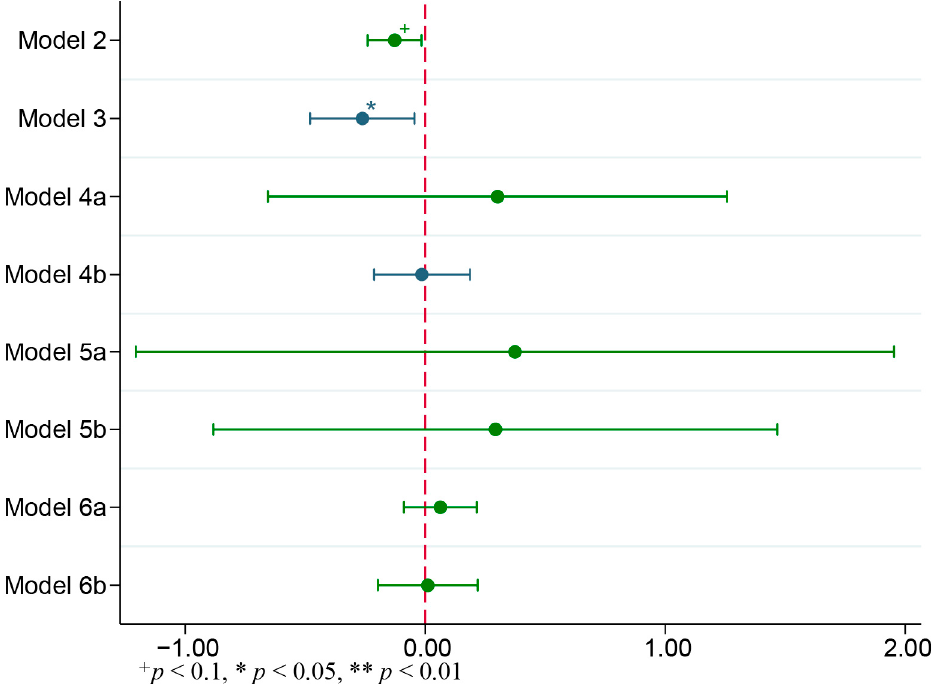
Figure 2. The regression results of all respondents. Note: Model 2: Distance to Parks; Model 3: Distance to Rivers; Model 4a: Coverage Ratio of Green Space; Model 4b: Coverage Ratio of Freshwater; Model 5a: Coverage Ratio of Forests; Model 5b: Coverage Ratio of Grass; Model 6a: Coverage Ratio of Parks; and Model 6b: Number of Parks.